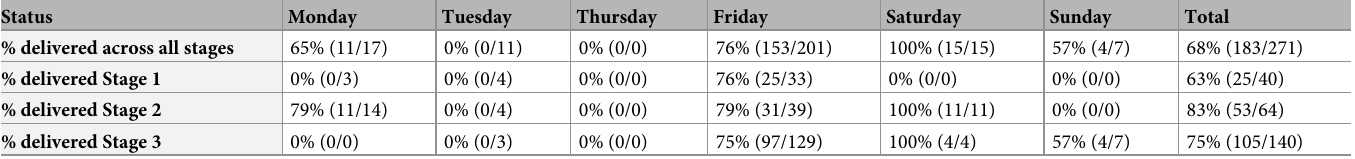
Table 4. SMS delivery status by day